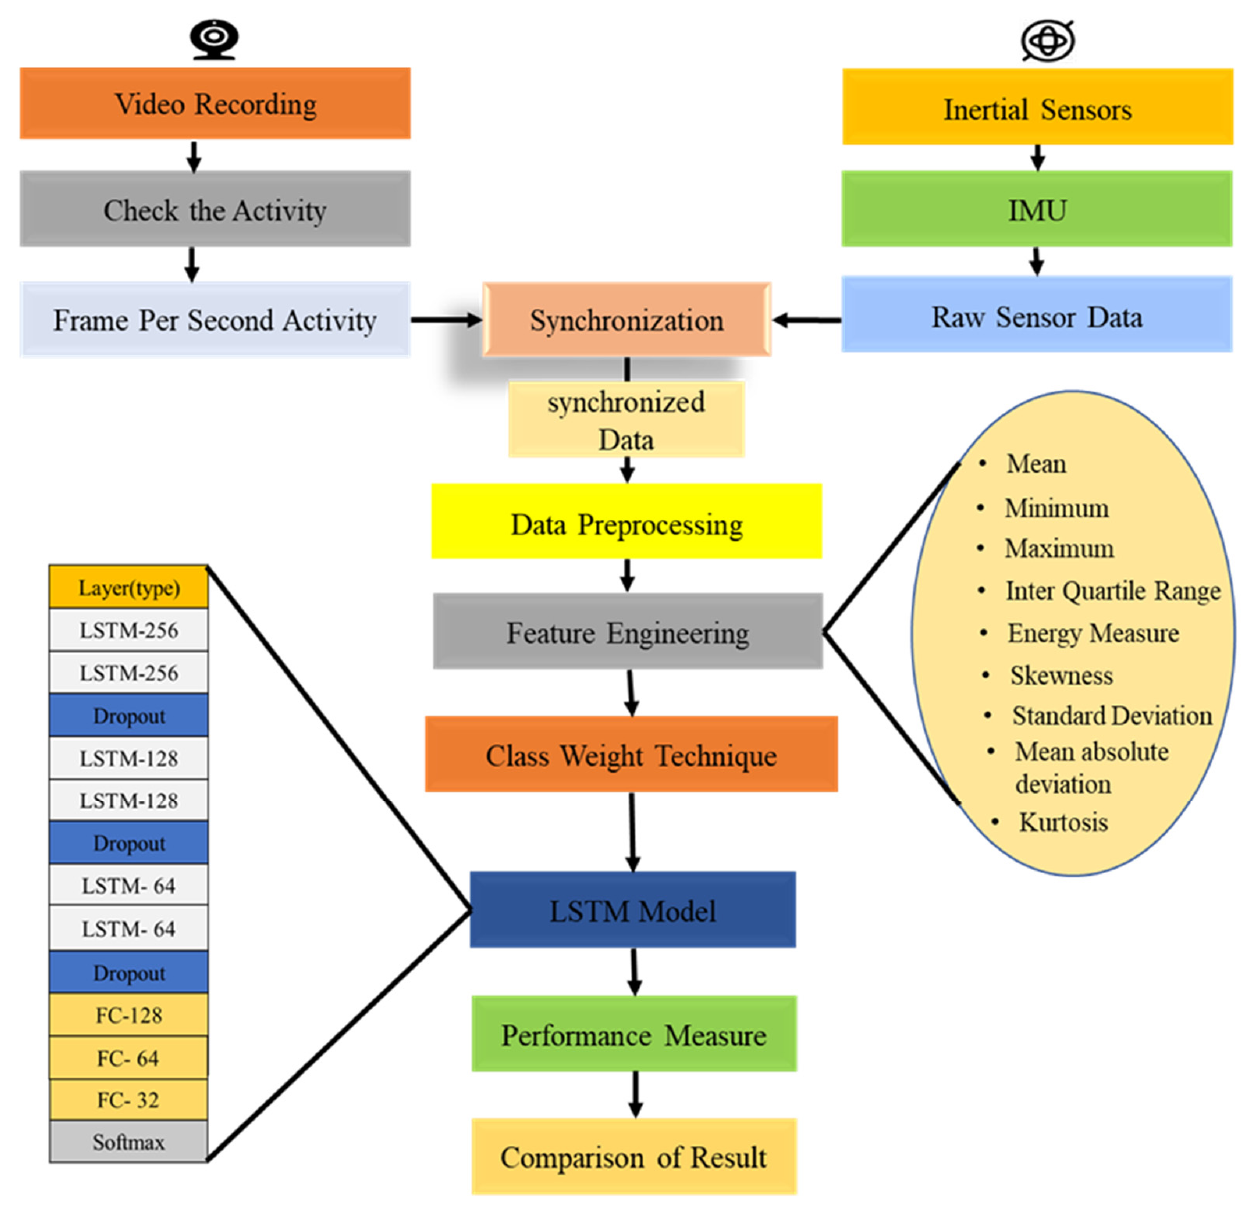
Figure 1. The architecture of proposed model.